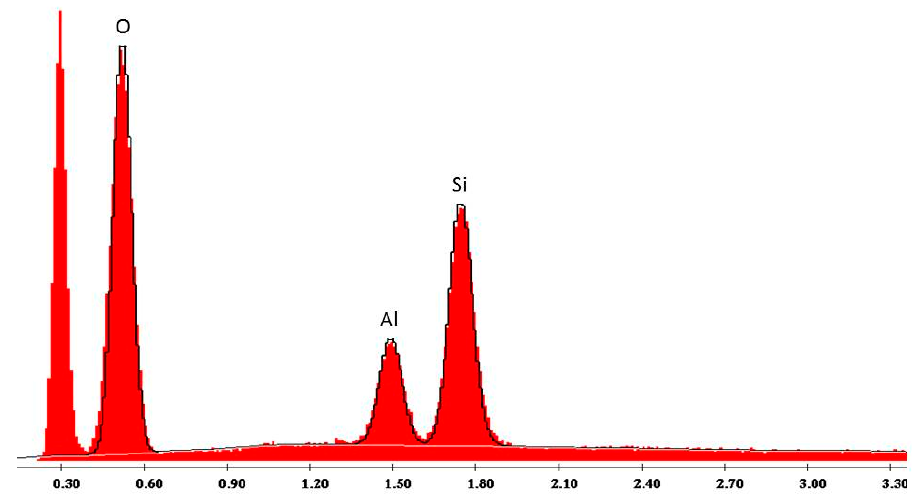
Figure 11. EDAX Analysis of PMMA surface sandblasted with Rocatec Pre and Rocatec Plus (110 μ m silicate-modified aluminum oxide, 2.8 bar).